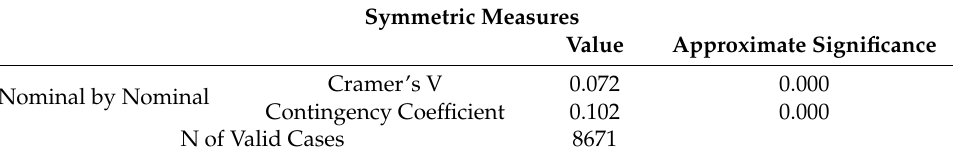
Table 22. Strength of dependence between variables. Source: own research.